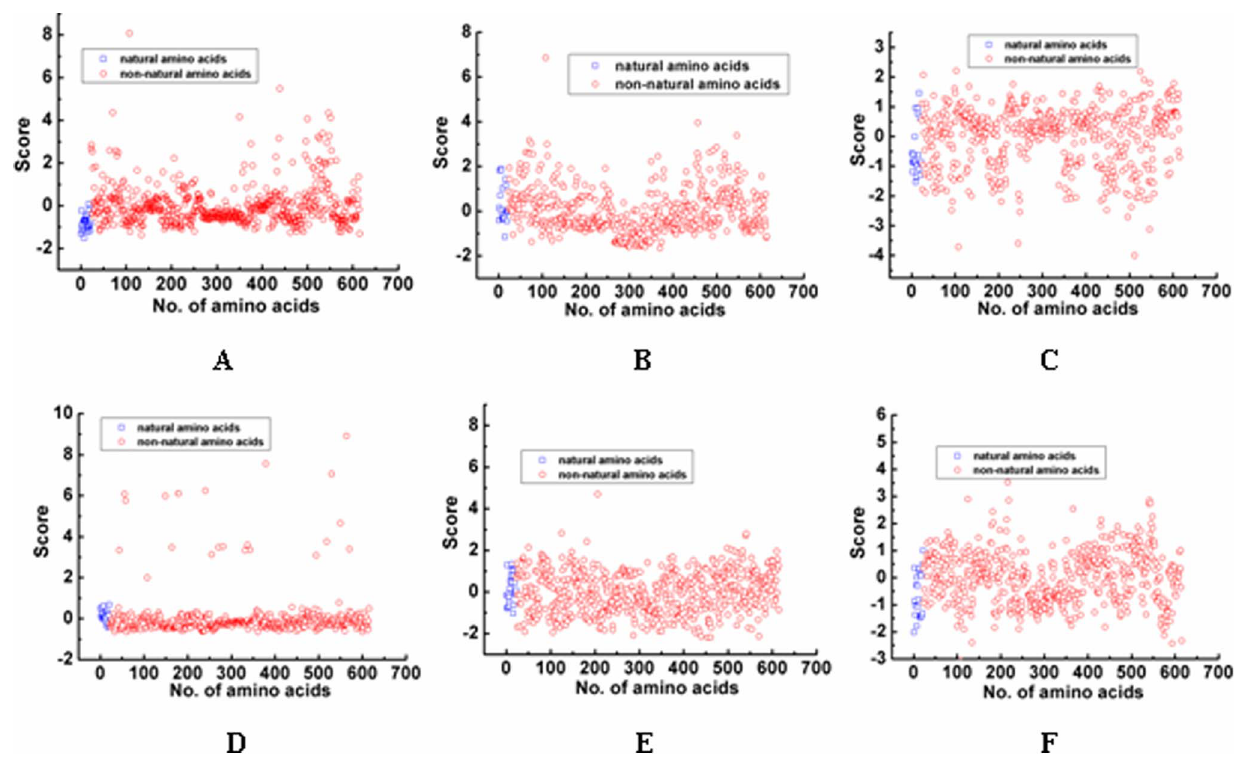
Figure 2. The difference of 22 natural amino acids and 593 non-natural amino acids on each factor. The A, B, C, D, E and F is the difference for geometric characteristics, H-bond, connectivity, accessible surface area, integy moments index, and volume and shape, respectively.